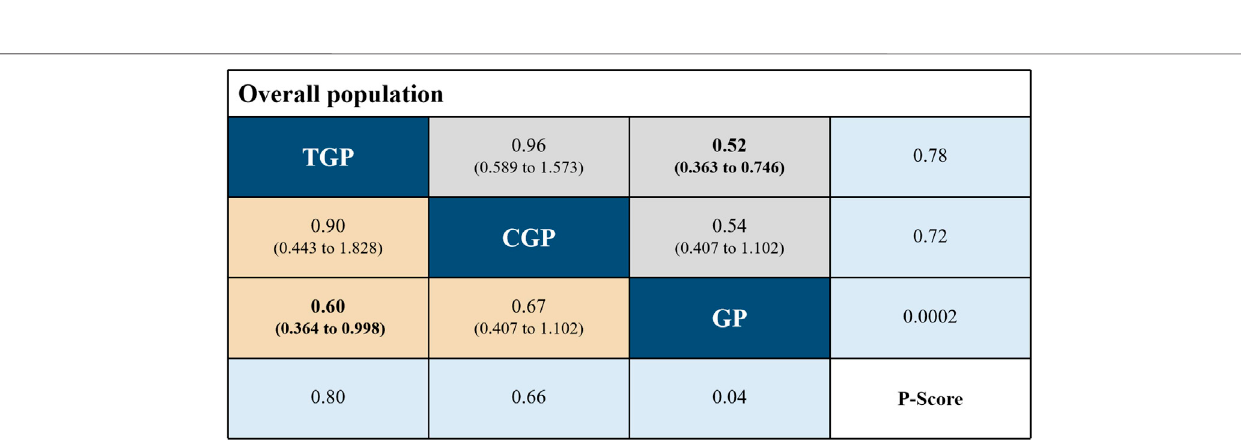
Frontiers in Pharmacology |